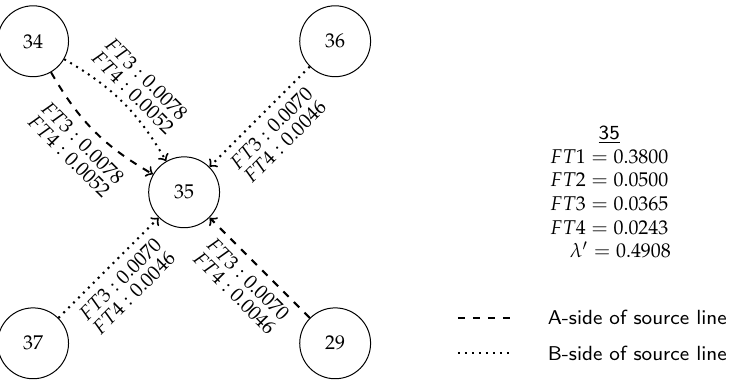
Figure 5. Contributions to fault type 3 (FT3) and FT4 for line 35 from adjacent lines. FT1–FT4 and adjusted failure rate for line 35. Annual